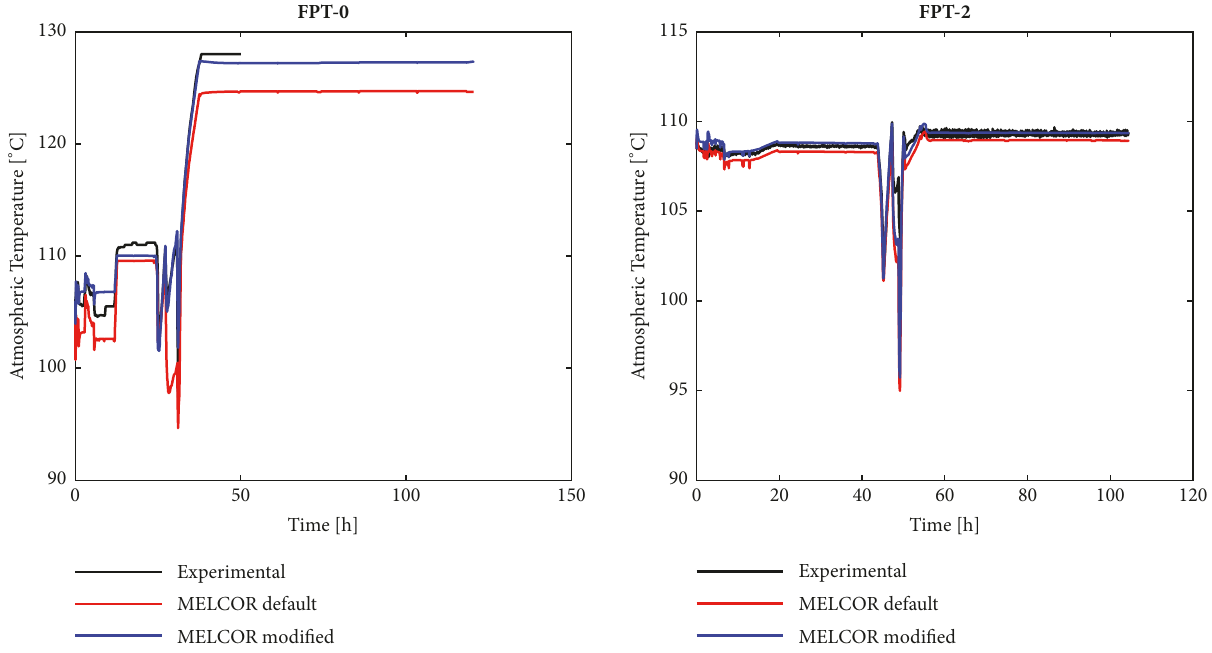
Figure 9: Influenceof theouterwall’s characteristiclengthvalues used by MELCOR on themean atmospherictemperatureduring thePh´ebus FPT-0 and FPT-2 tests.